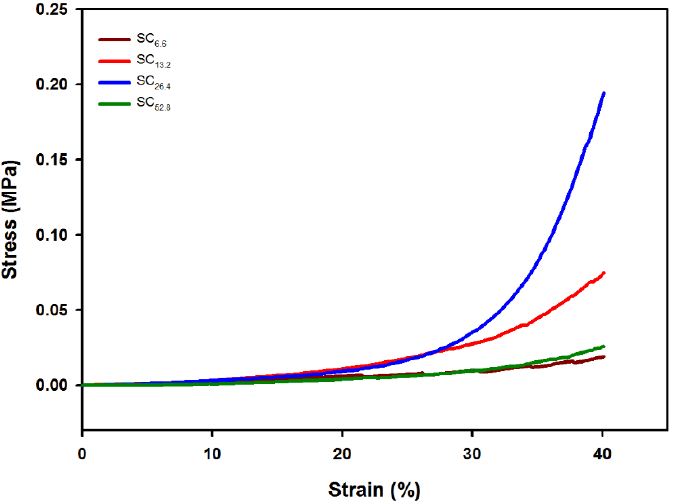
Figure 9. Compressive strain curves of SCx with different Cr 3+ concentrations.